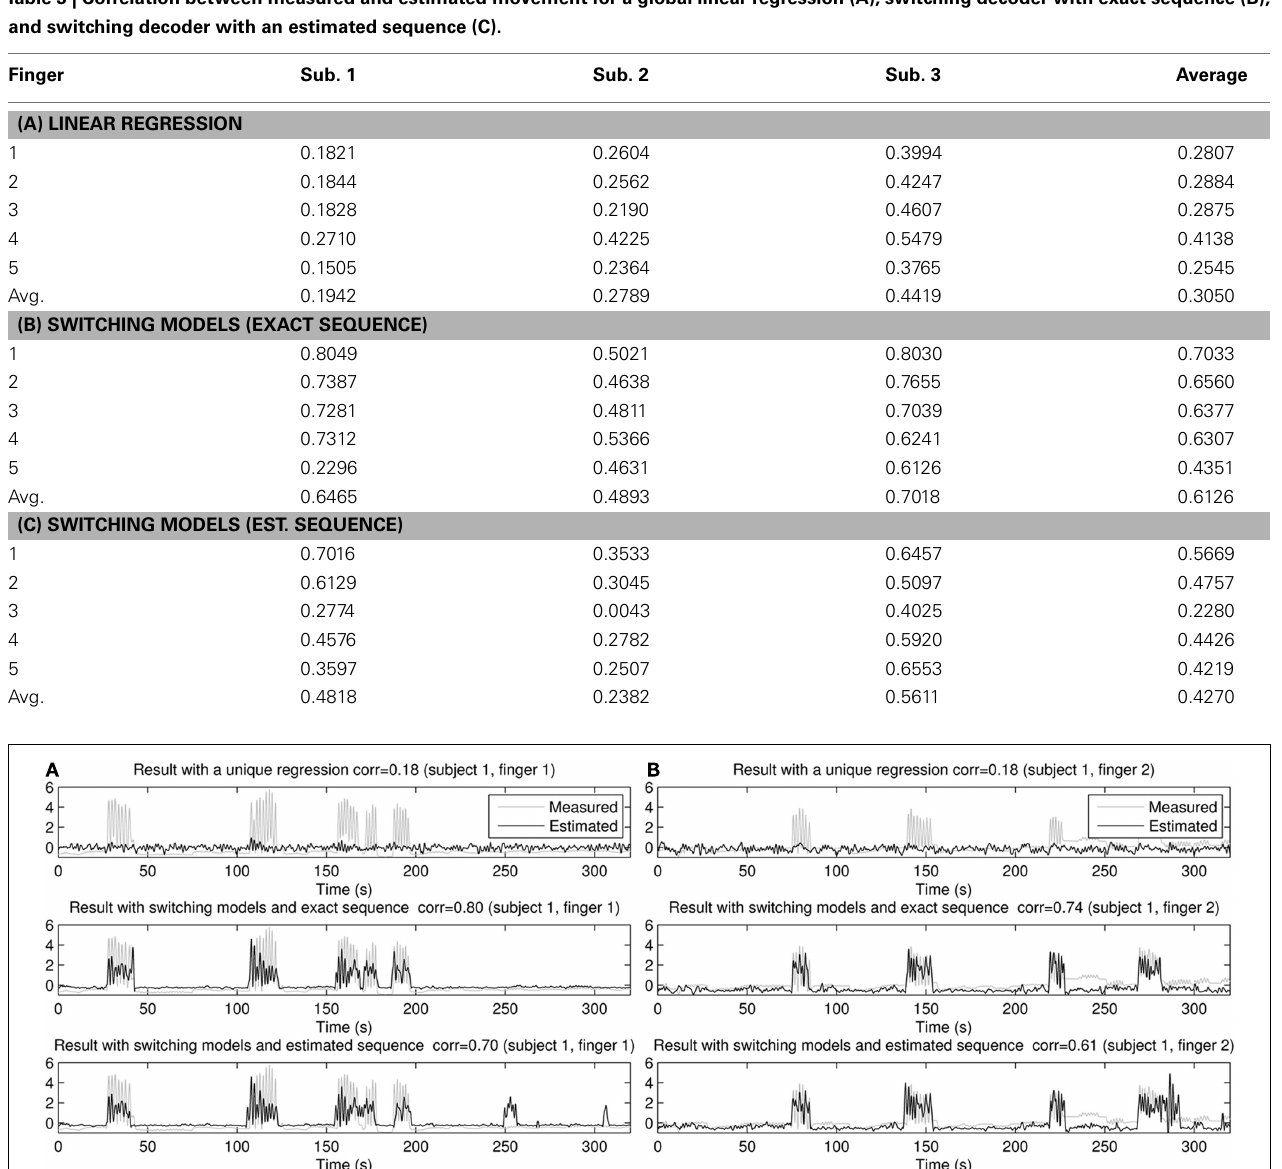
an estimated moving finger segmentation. (A) Correspond to predictions of the first finger of subject 1 and (B) Correspond to the prediction of the second finger of subject